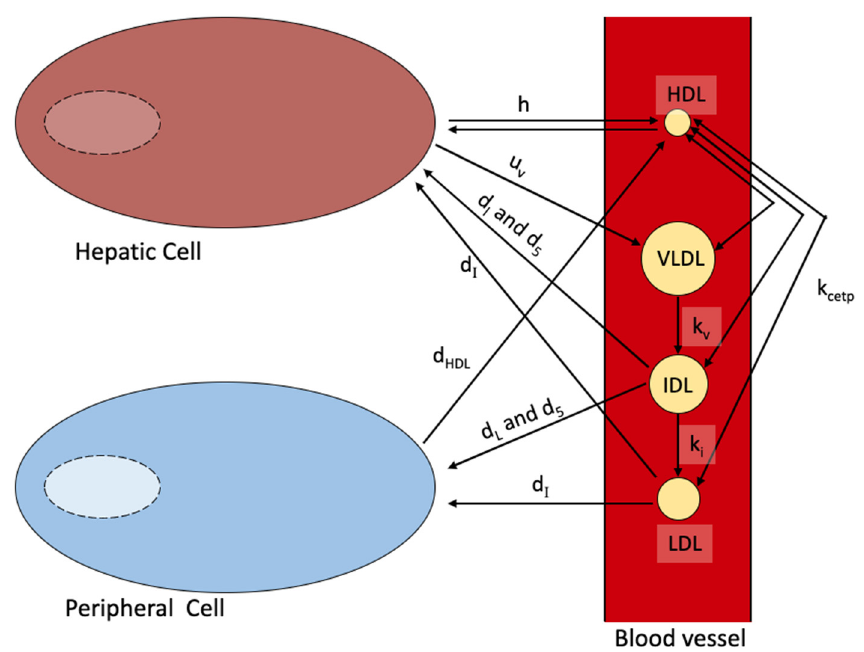
Figure 6. Cholesterol blood plasma model (Model 8). VLDL leaves the liver and is converted to LDL and then IDL. LDL and IDL enter both liver and peripheral cells as well as exchange cholesterol with HDL using CETP. HDL takes cholesterol from peripheral cells and transfers cholesterol to liver cells. The equations of Model 8 are shown in A51 through A53 in Appendix A [22].